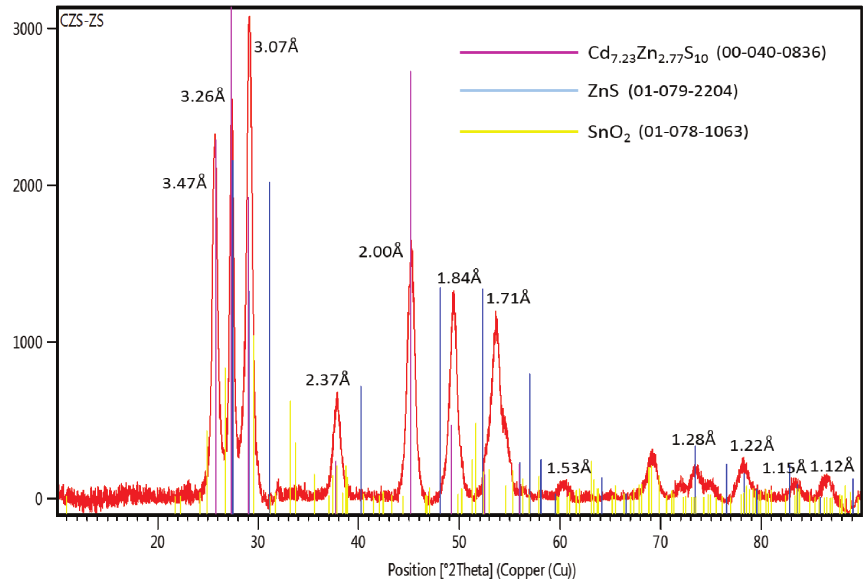
Figure A2: Sticky pattern matching with original peak pattern of CZS-ZS thin films (Indexed d-spacing) synthesised via AACVD technique at